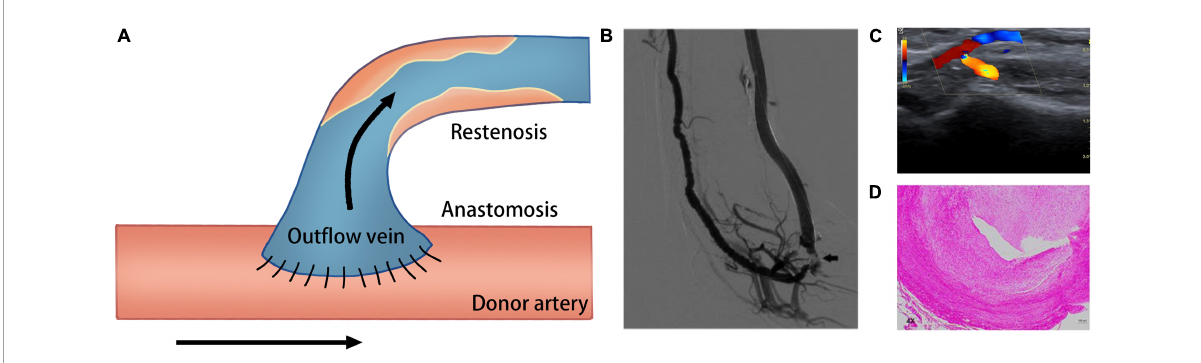
FIGURE1 Schematic of creation of the AVF. (A) Creation of AVF with end-to-side technique. (B) Venography of the AVF; arrow shows the occlusion of the arterial inflow (233). (C) Duplex ultrasound image shows fistula occlusion of the arterial inflow (234). (D) Hematoxylin and eosin staining shows neointima formation in the venous outflow tract of AVF